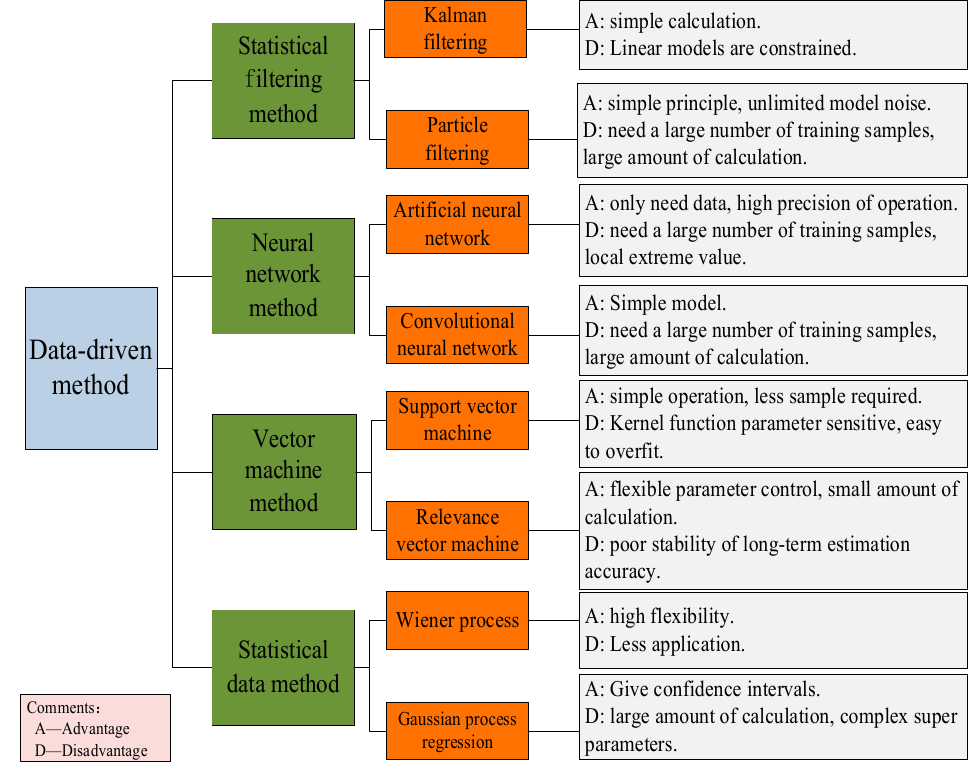
Figure 6. Summary of Data-driven methods.